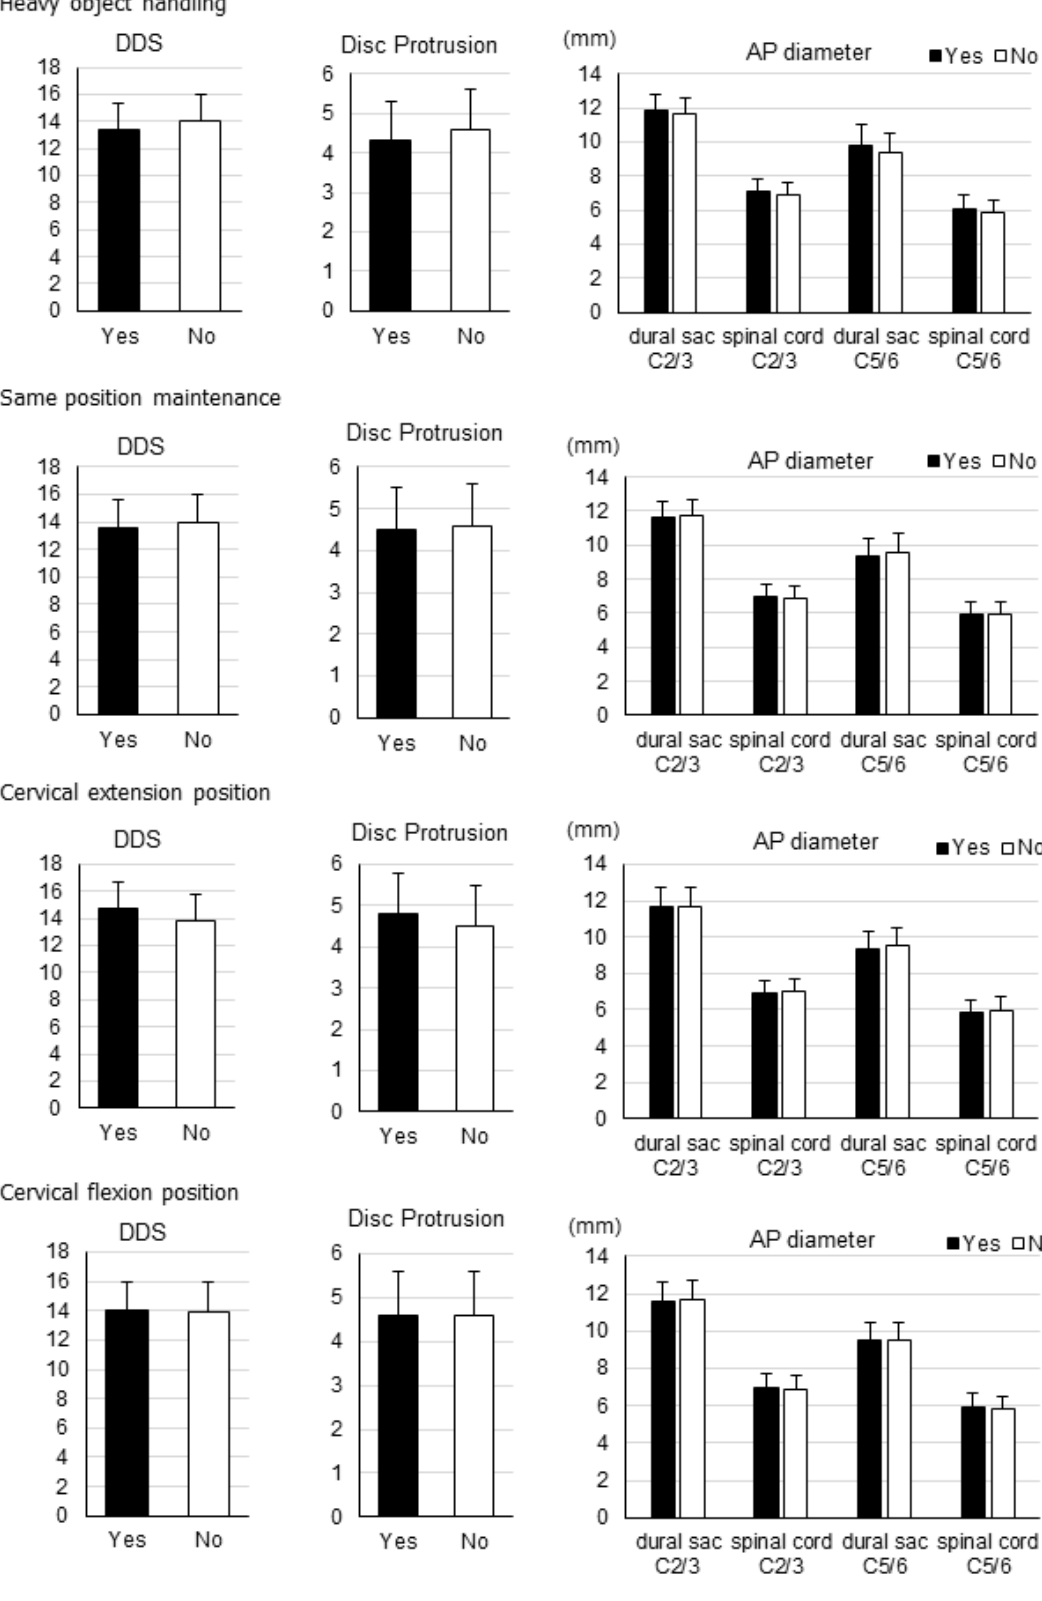
Figure 3. Disc degeneration data by labor type for males. Overall disc degeneration score (DDS), number of disc protrusions, and anteroposterior (AP) diameters of the dural sac and spinal cord at the C2/3 and C5/6 levels for each labor type in males.